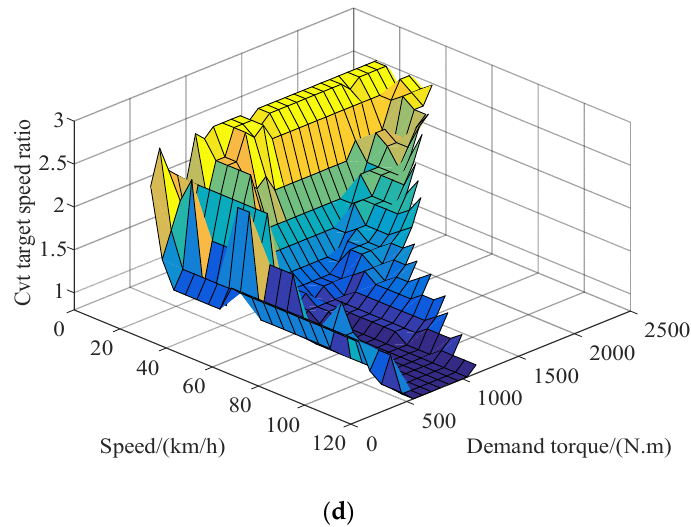
Figure 12. Optimization results in oil-electro-hydraulic hybrid drive mode: ( a ) hydraulic pump / motor target torque; ( b ) engine target torque; ( c ) motor target torque; ( d ) CVT target speed ratio.